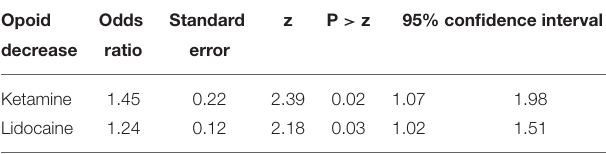
TABLE 6 | Generalized estimation equation (GEE) model with exchangeable correlation structure.